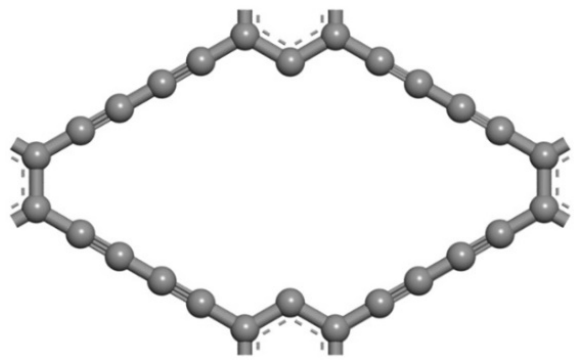
Figure 4. Schematic diagram of the γ -VGDY models.